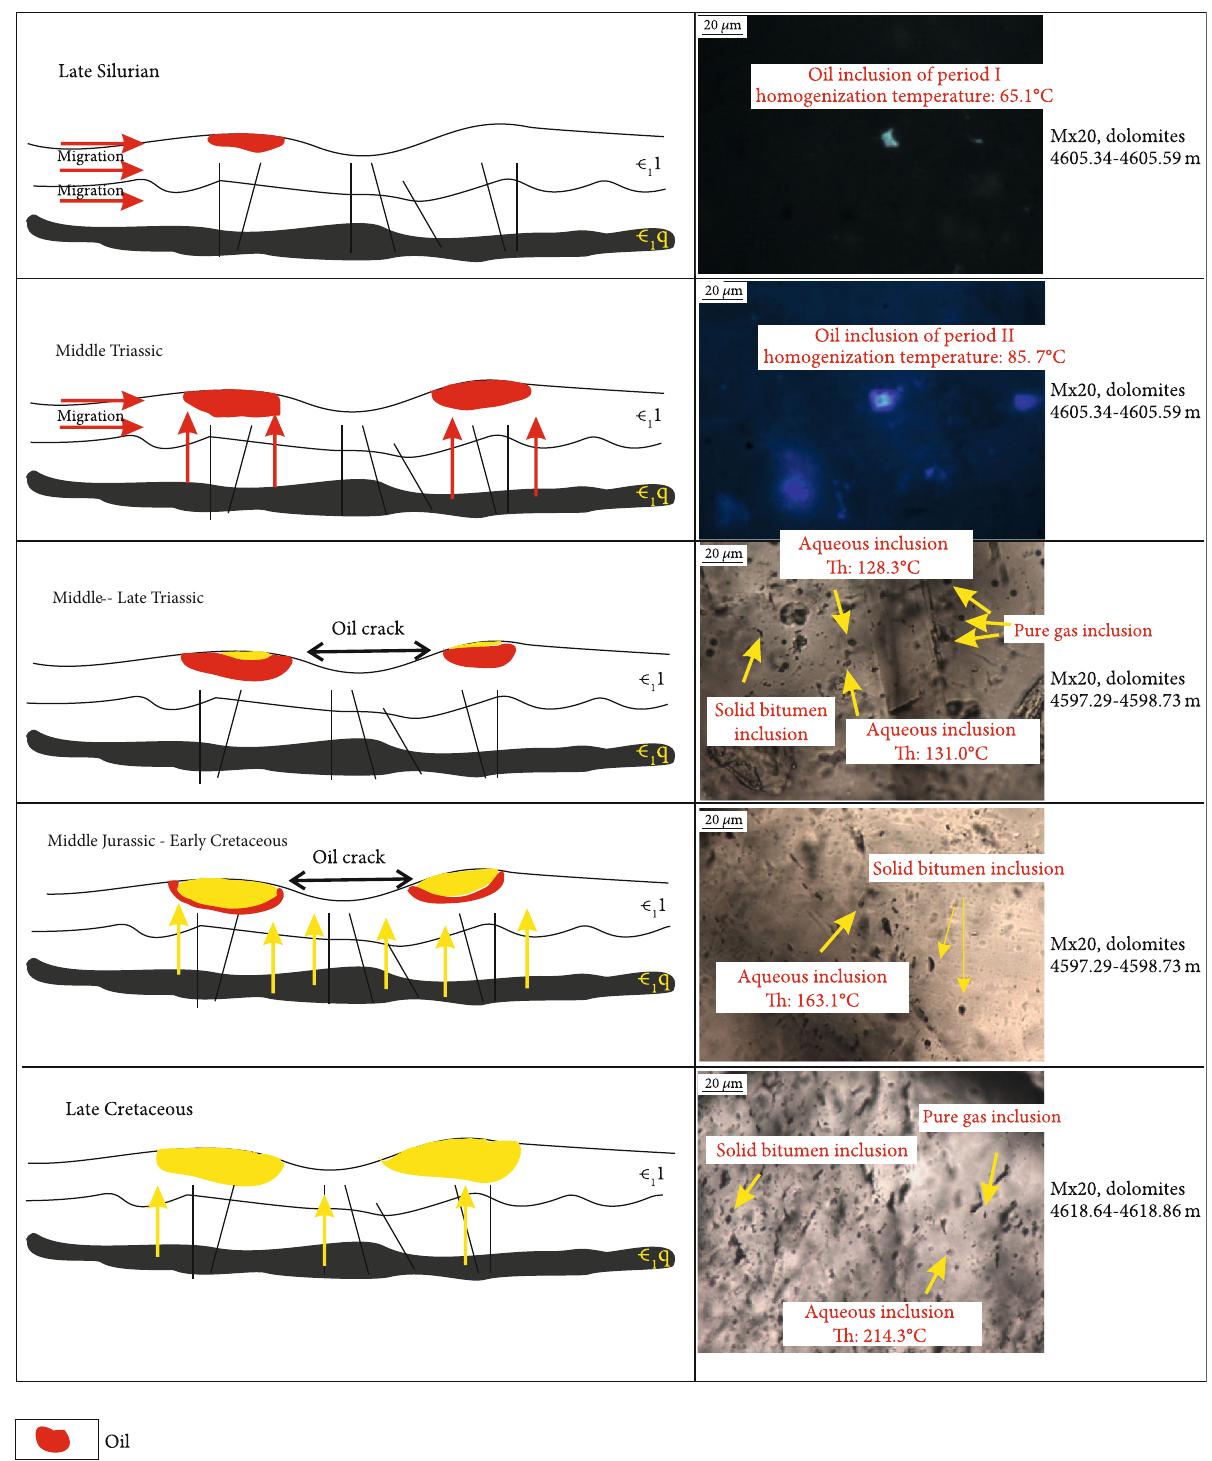
Figure 11: Diagram of the stages of modelled hydrocarbon accumulation evolution in the Longwangmiao Formation of the Moxi